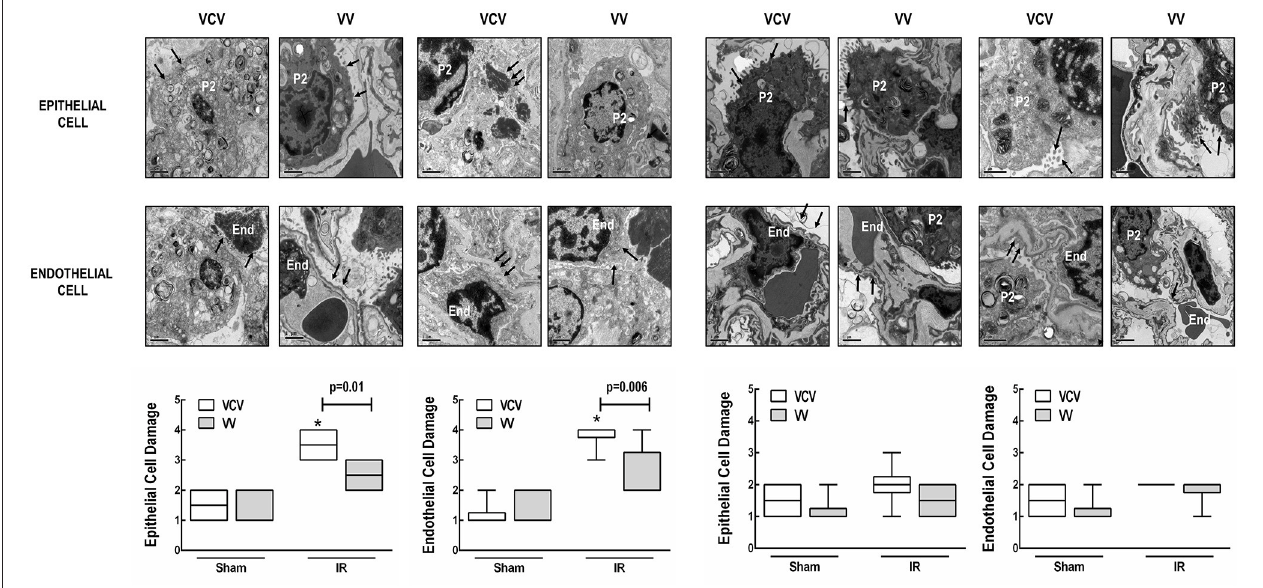
FIGURE 3 | Electron microscopy of lung ischemia-reperfusion (IR) injury and sham clamping in left (injured) and right (contralateral) lungs, in animals ventilated in volume-controlled (VCV) or variable controlled ventilation (VV). Photomicrographs are representative of epithelial (type 2 epithelial cell, P2) and endothelial (End) cell damage (arrows) obtained from lung sections derived from 6 animals. Lung injury score (epithelial and endothelial cell damage) assessed by electron microscopy. Values represent medians and whiskers represent the 10–90 percentile range of 6 animals in each group. Two-way repeated-measures ANOVA followed by Bonferroni’s post-hoc test ( p < 0.05). *Significantly different from Sham group ( p <